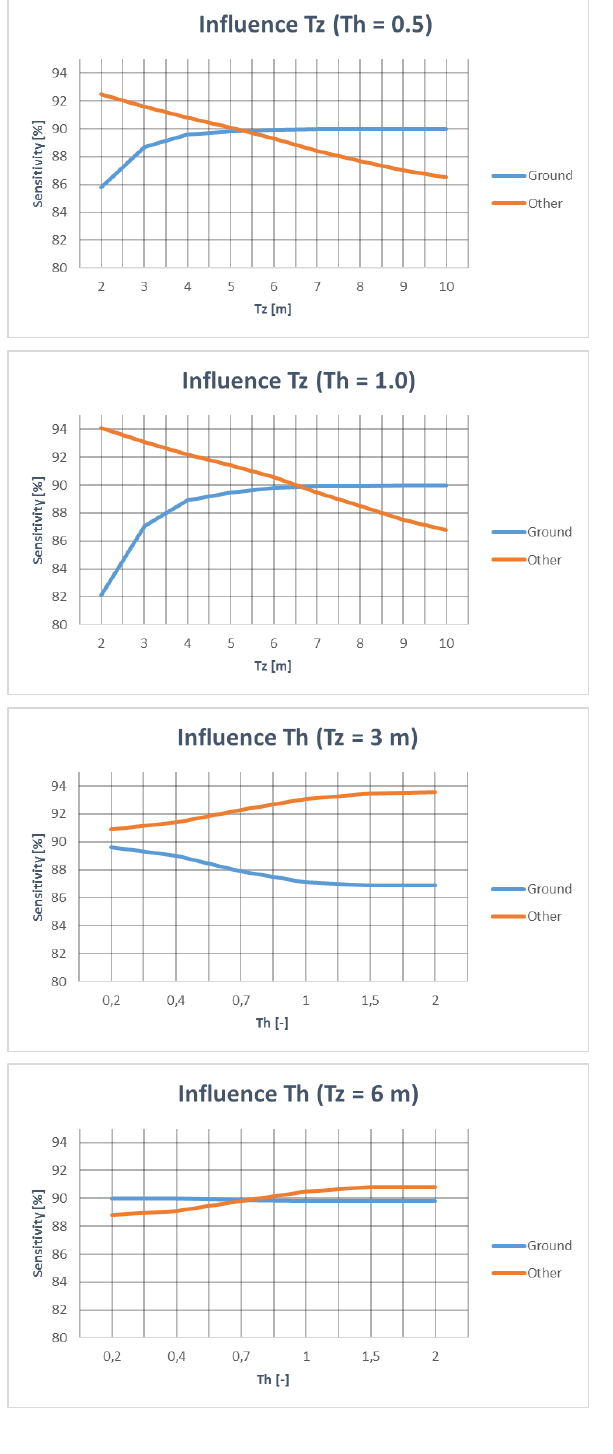
Figure 11. Influence of the parameters Th and Tz to the ground detection. The two columns show different maximum Voxel dimensions (see